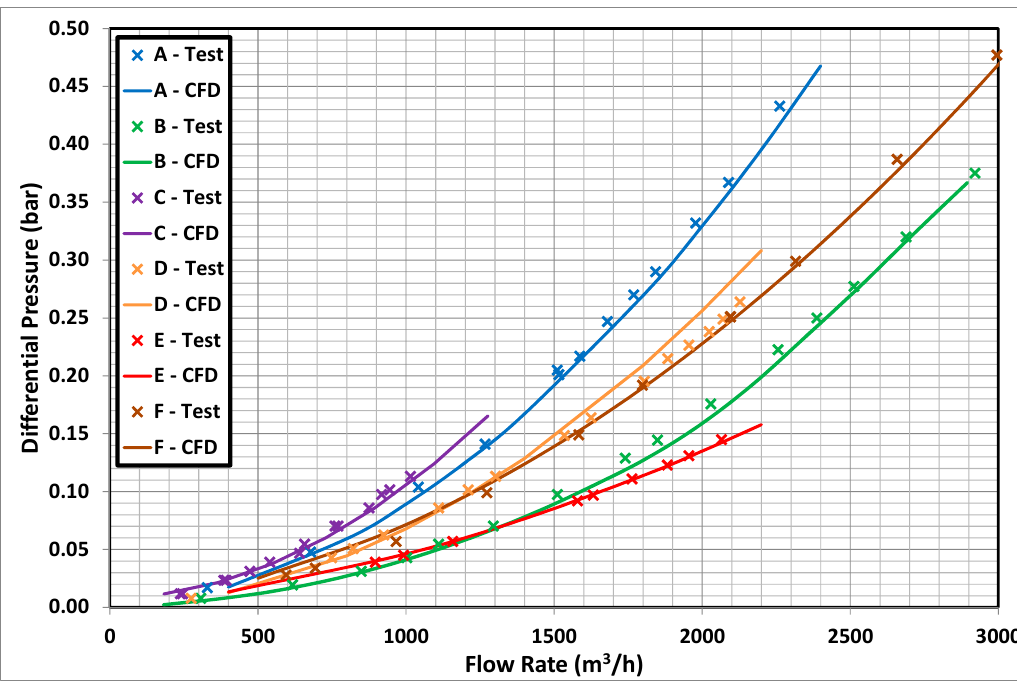
Figure 9. Comparison of the curve of an air valve: experimental data vs. CFD analysis.